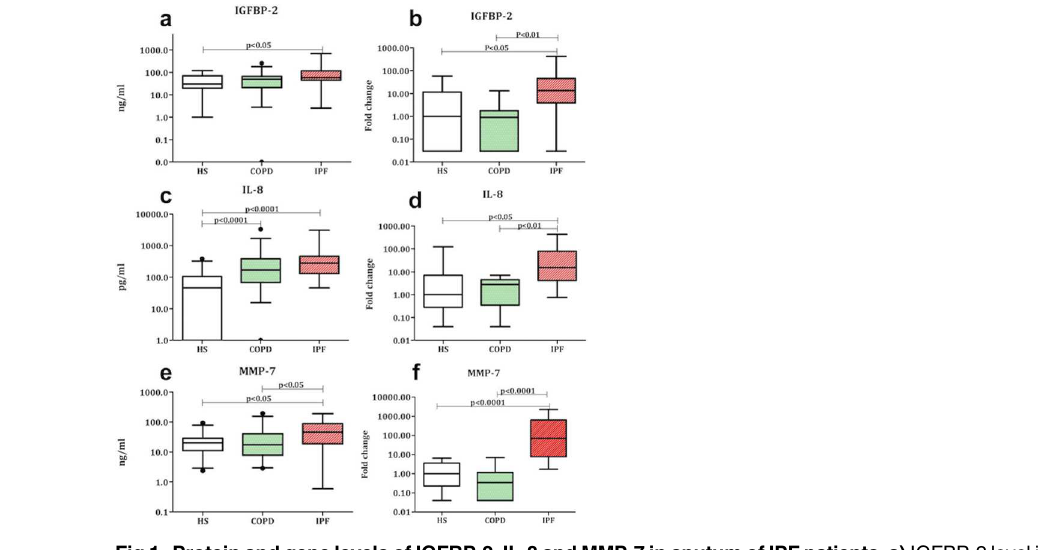
Fig 1. Protein and gene levels of IGFBP-2, IL-8 and MMP-7 in sputum of IPF patients. a) IGFBP-2 level in supernatant showinga significant increasein IPF comparedto HS. b) Sputum cell geneexpression of IGFBP- 2 showinga significantincreasein IPF patientscomparedto COPD and HS. c) IL-8 level in supernatant showinga significantincreasein COPD and IPF comparedto HS. d) Sputum cell geneexpressionof IL-8 showinga significantincreasein IPF comparedto COPD andHS. e) MMP-7 level in supernatant showinga significantincreasein COPD and IPF comparedto HS. f) Sputum cell geneexpressionof MMP-7 showinga significantincreasein IPF comparedto COPD and HS.